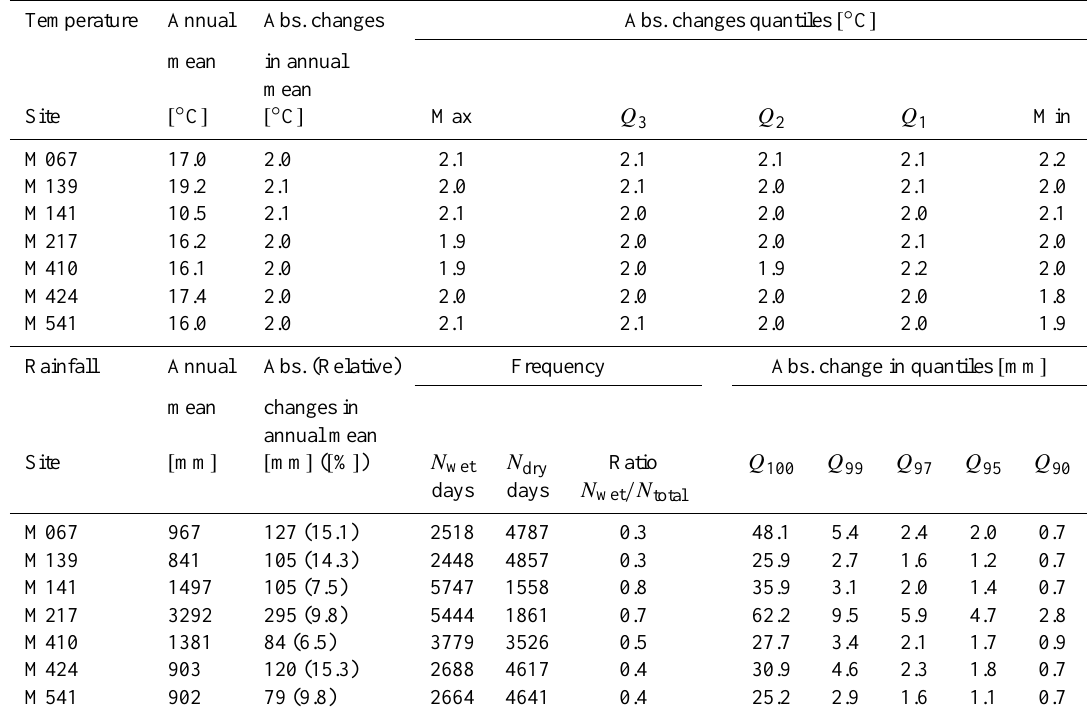
Table 4. Impact indicators for temperature and rainfall downscaled output series for 2045–2065, scenario A2. Temperature Annual Abs. changes Abs. changes quantiles [ ◦ C